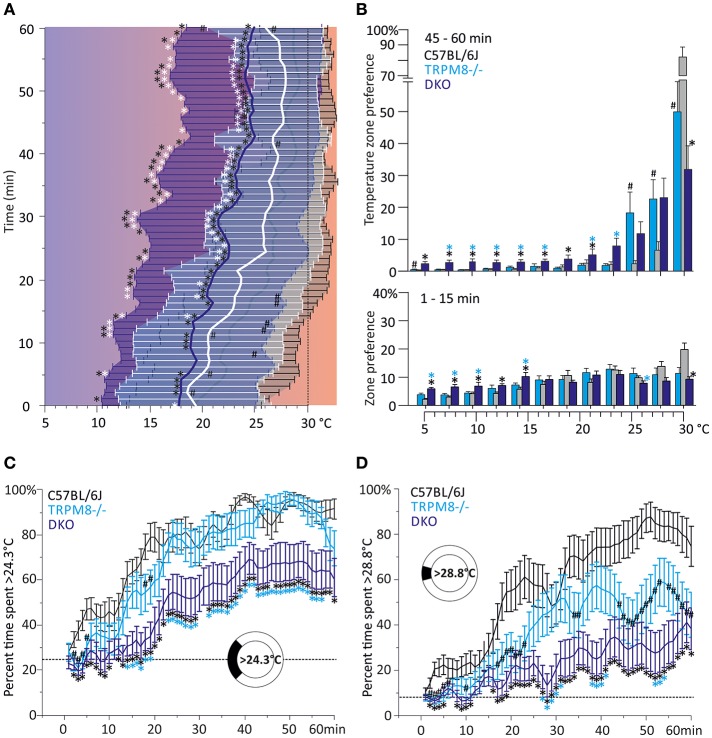
Characterization of cold avoidance behavior in DKO in the 5–30°C gradient. (A) Preference temperature time course in minute resolution illustrates a significant segregation of weighted preferred temperatures of DKO (n = 20, dark blue) and TRPM8−/− (n = 19, cyan with white whiskers) and C57BL/6J mice (n = 20, gray). Note that DKO migrate to warmer zones, but have a higher SD than any other of the strains illustrating a broader tolerance for cold temperatures. Data are 3pt averaged. Error bars are SD (2nd moment). (B) Zone preference histograms of exploratory (1–15 min, bottom) and thermal preference behavior (46–60 min, top) of C57BL/6J (gray), TRPM8−/− (cyan), and DKO (blue). Exploratory behavior (bottom) illustrates that DKO avoid colder floor temperatures less than TRPM8−/− and all other strains. The deficit in cold avoidance of DKO becomes larger at the end of the observation time and leads to occupation of cooler floor temperatures (top). Error bars indicate S.E.M. (C,D) Time courses of thermal selection. Percent time spent (C) >24.3°C and, (D) >28.8°C calculated in 1 min resolution (average of 60 values per min) and subjected to 3 pt averaging. (C) Cold avoidance deficits of DKO become apparent in comparison to C57BL/6J and TRPM8−/−, but DKO still prefer warmer areas and require more time to locate there (dashed line: 25.0% random probability). (D) Using the 30°C field as discriminator, makes graded phenotypic differences between all three strains apparent (dashed line: 8.3% random probability). Error bars indicate S.E.M. Asterisks in black and cyan indicate significant differences for p < 0.05 (ANOVA) between DKO and C57BL/6J and DKO and TRPM8−/−, respectively. Black #: significant differences for p < 0.05 (ANOVA) between TRPM8−/− and C57BL/6J.